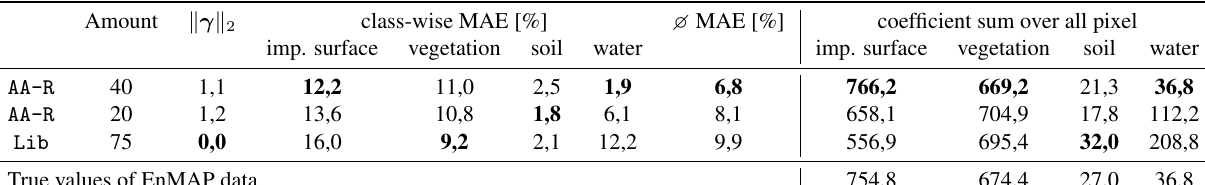
) and class-wise MAE , reconstruction error (cid:107) γ (cid:107) 2 , and class-wise sum over all fractions based on the sub-pixel quantification of the EnMAP reference data. In the first two rows are the results for the archetypal reconstruction using a different number of archetypes (40 and 20) contained in the set A 1 and the set A 2 , denoted by AA-R . The last row contains the results for the reconstruction using the manually designed spectral library ( Lib ) with all contained spectra (75). Bold numbers indicate the